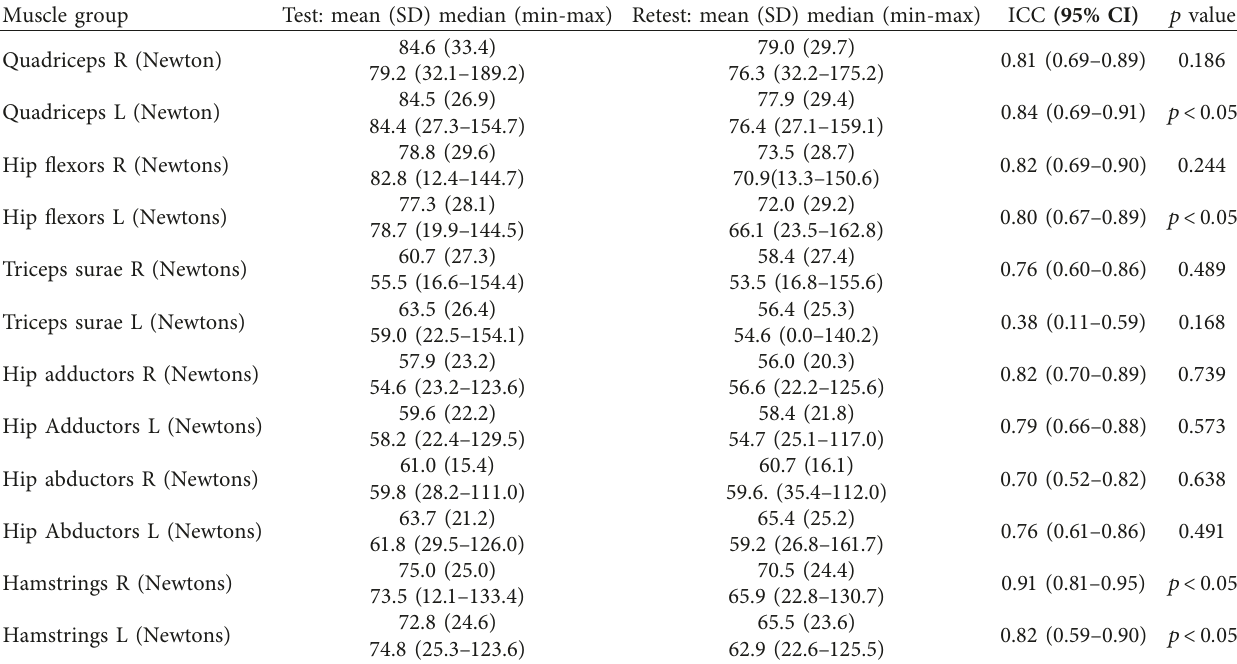
Table 2: Test-retest: reliability outcomes.